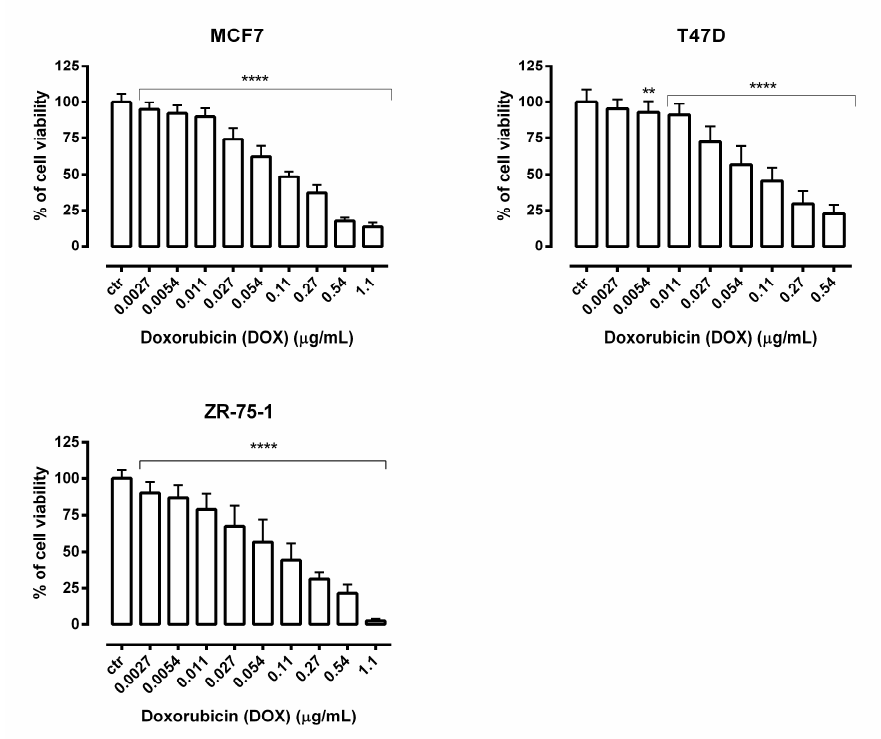
Table 1. The anti-proliferative effects of palmatine (PLT) and doxorubicin (DOX) administered sin- gly in human breast cancer cell lines measured in vitro by the MTT assay. Data are median inhibi- tory concentrations (IC 50 values in µg/mL ± SEM) of PLT and DOX administered separately in cancer cell lines.